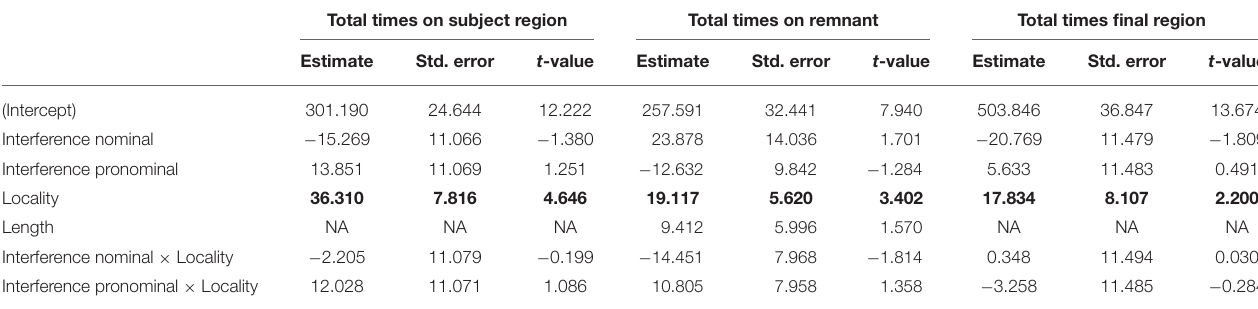
TABLE 7 | Experiment 2: linear mixed effects regression models for total times on the sentence initial, remnant, and sentence final regions.